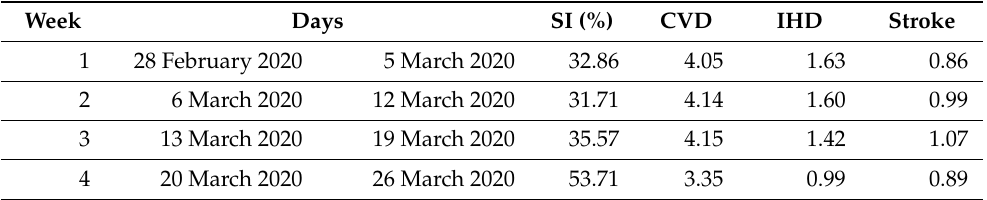
Table 1. Weekly social isolation (SI) and deaths per 100,000 inhabitants from cardiovascular disease (CVD), ischemic heart disease (IHD), and stroke.